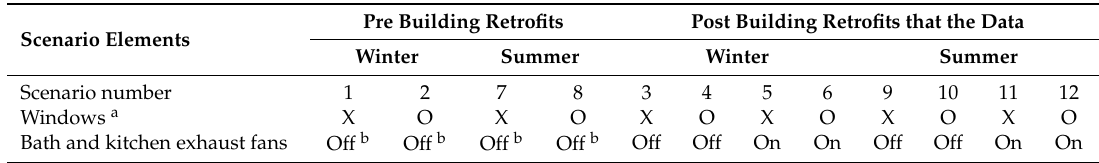
Table 1. Multi-factorial scenarios of each model run representing changes in building retrofit status, season, window opening and exhaust fan